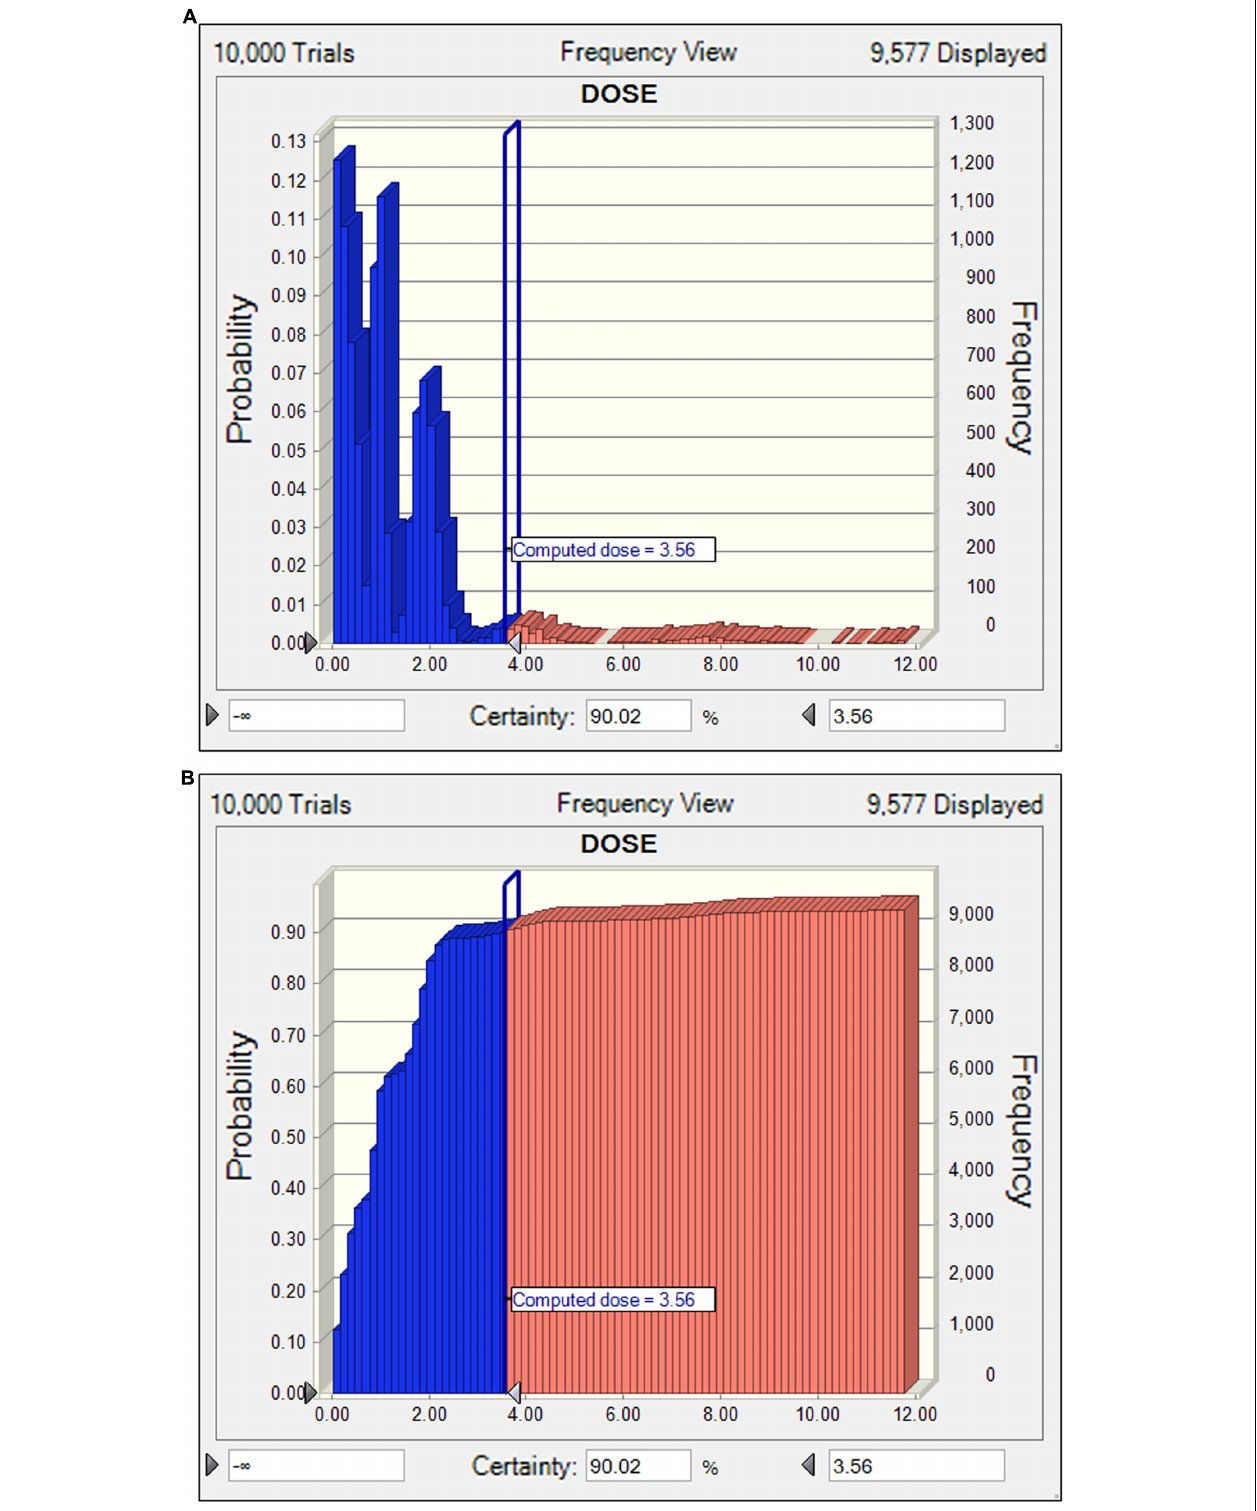
FIGURE 6 | The non-cumulative (A) and cumulative (B) distributions of tulathromycin doses for S. suis , as predicted by a PK/PD model for a duration of 5 days activity in terms of probability of target attainment (PTA). The vertical bar indicates the computed target dose at the cumulative PTA of 90%. Dose (0–12 mg/kg) is indicated on the x